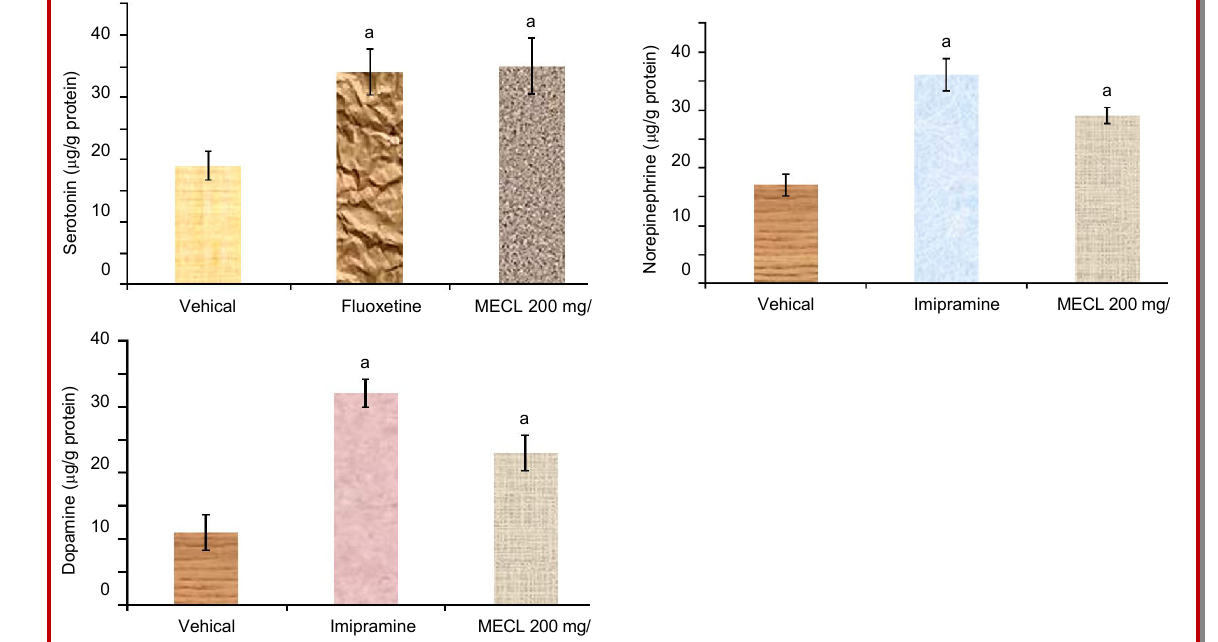
Figure 1: Effect of methanolic leaves extract C. limetta (200 mg/kg) on serotonin (A), norepinephrine (B) and dopamine (C) after the trial of antidepressant model All values are mean ± SEM; n=6; a p<0.05 compared to